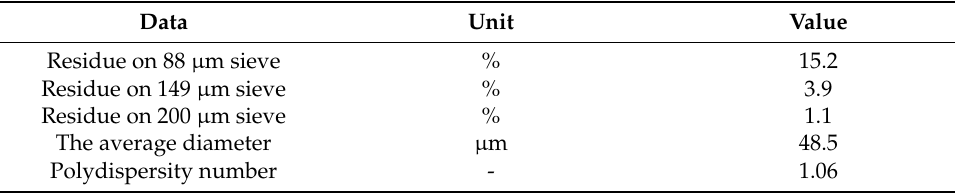
Table 3. Coal granulation—additional burner (between level of OFA I and II).